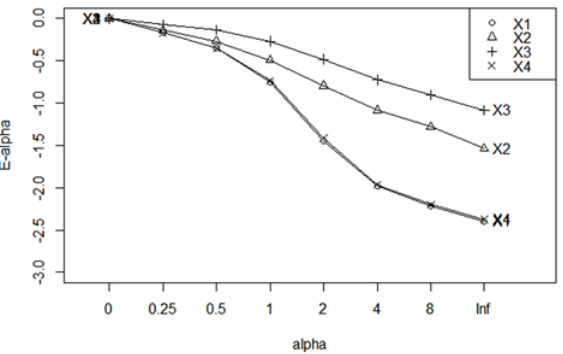
F IGURE 6: Rényi evenness profiles of bees for separate habitats; marked points along each profile represent randomly selected sampling points for each habitat: X1-Crop fields, X2- Fallow farmland, X3-Forest core, X4-Forest edge Effect of increasing distance from forest on bee diversity and